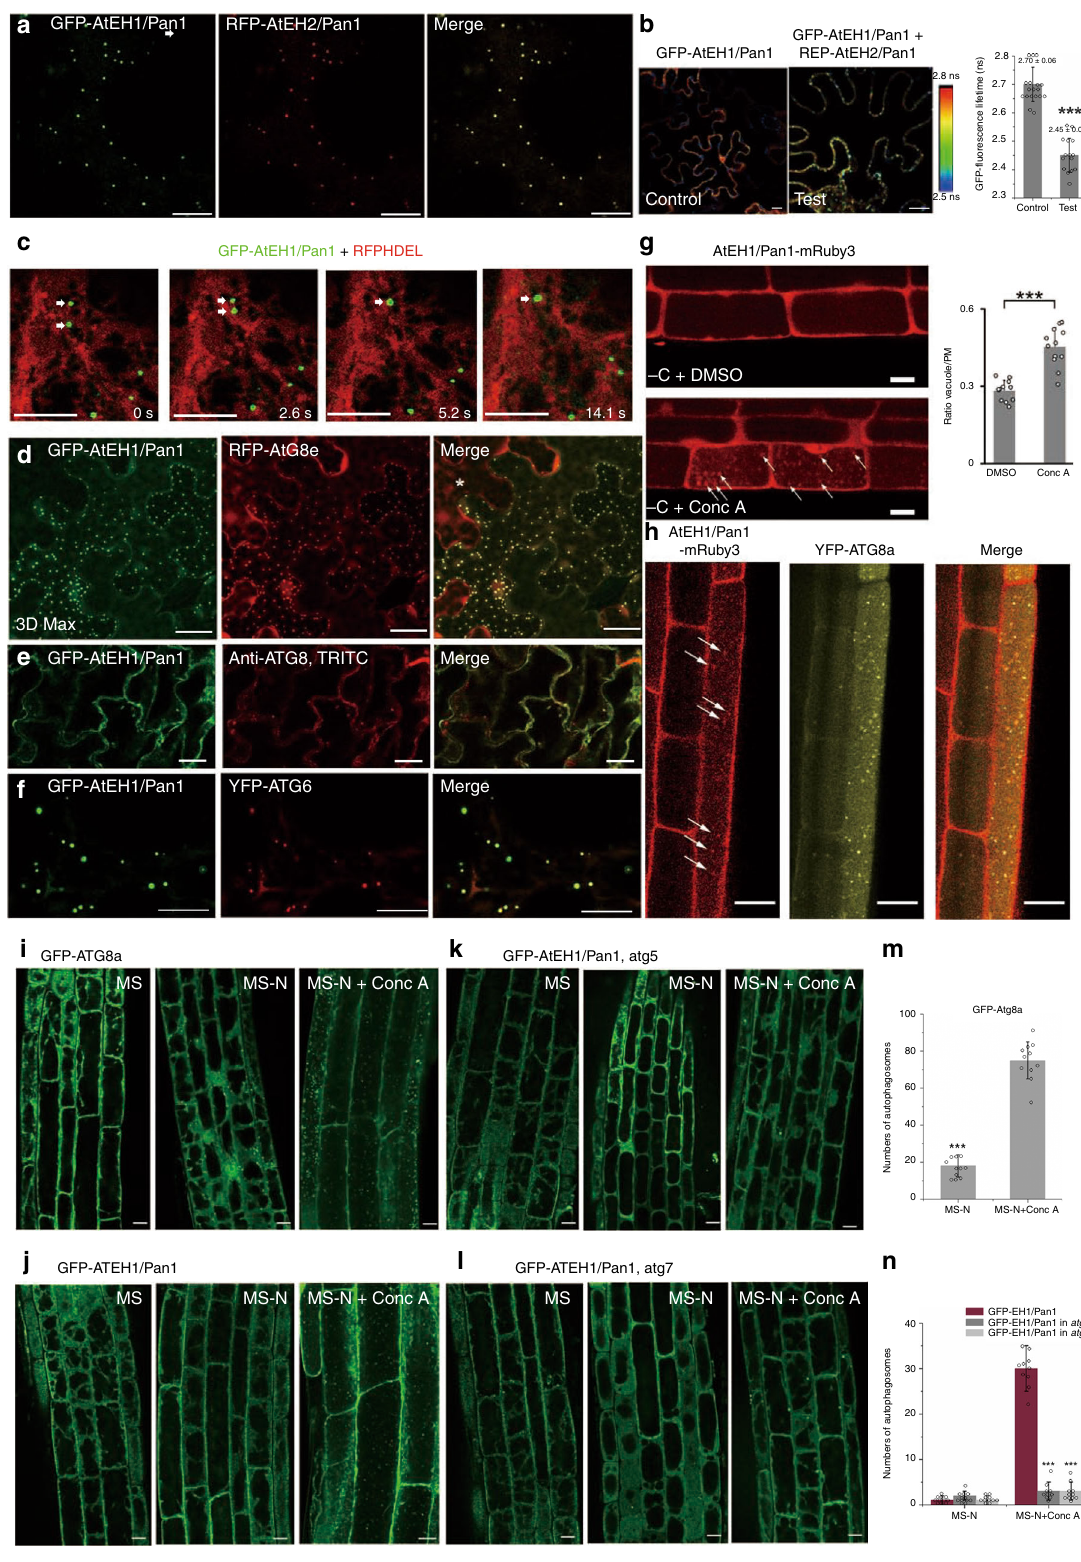
GFP-AtEH1/Pan1 with the EPCS resident proteins, VAP27-1 and SYT1. Transient co-expression of GFP-AtEH1/Pan1 with VAP27-1-YFP in N. benthamiana revealed a strong co- localization between AtEH1/Pan1-labelled autophagosomes